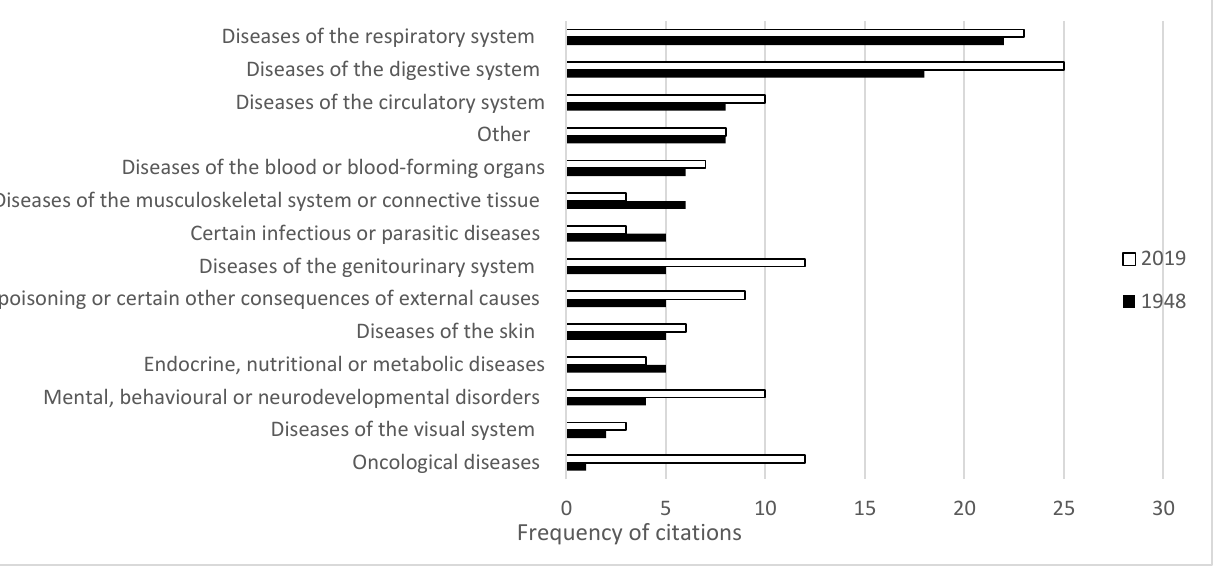
Figure 3. Indications for the use of medicinal herbal materials.